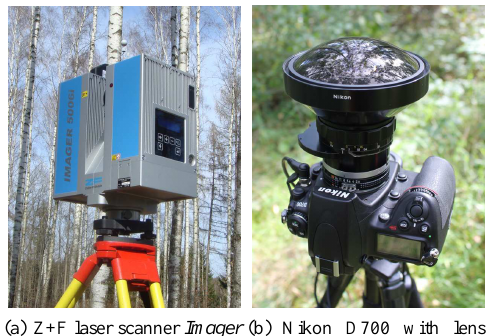
Figure 1: Instruments for data acquisition